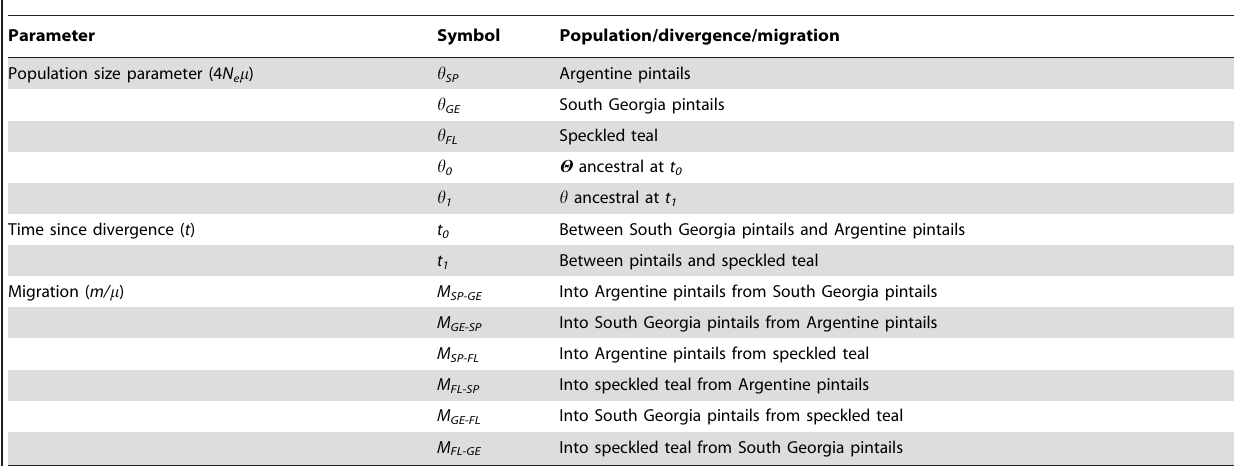
Table 2. Estimated parameters in the three-population IMa2 analysis.